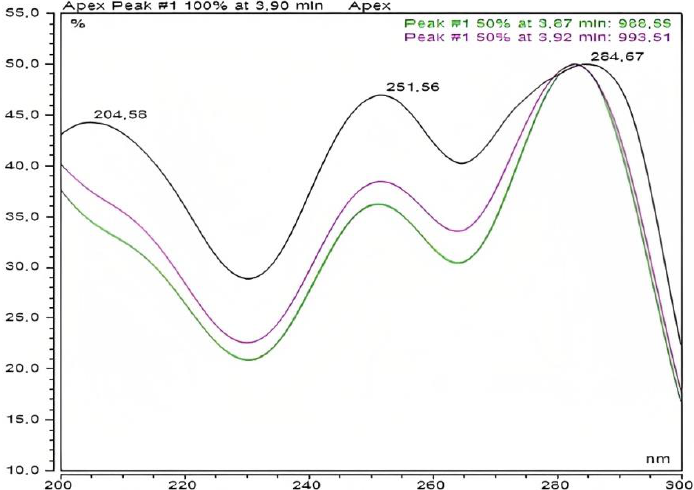
Figure 3. UV/Vis absorption spectrum of 2-(5-{6-[5-(Carboxymethyl)-2-thioxo-1,3,5-thiadiazinan-3-yl]butyl}-6-thioxo-1,3,5-thiadiazinan-3-yl)-ethanico acid (JH1). On the X-axis is represented the wavelength (nm) vs. absorbance on the Y-axis.